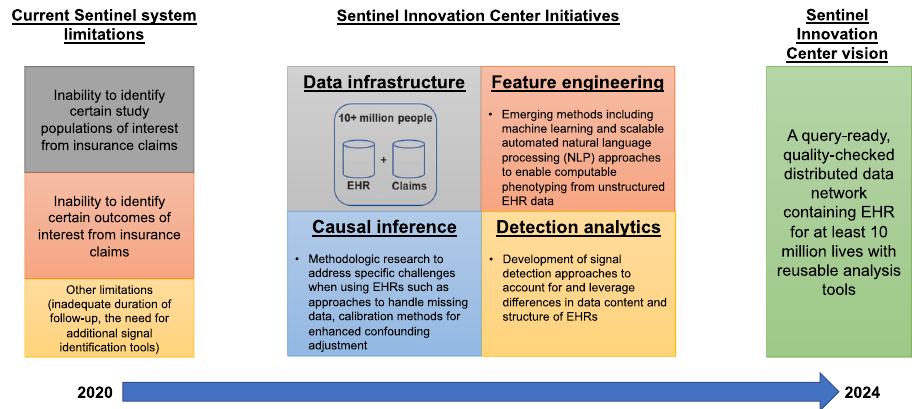
Fig. 3 The Sentinel Innovation Center initiatives and vision. Arrow at the bottom indicates timeline for the proposed